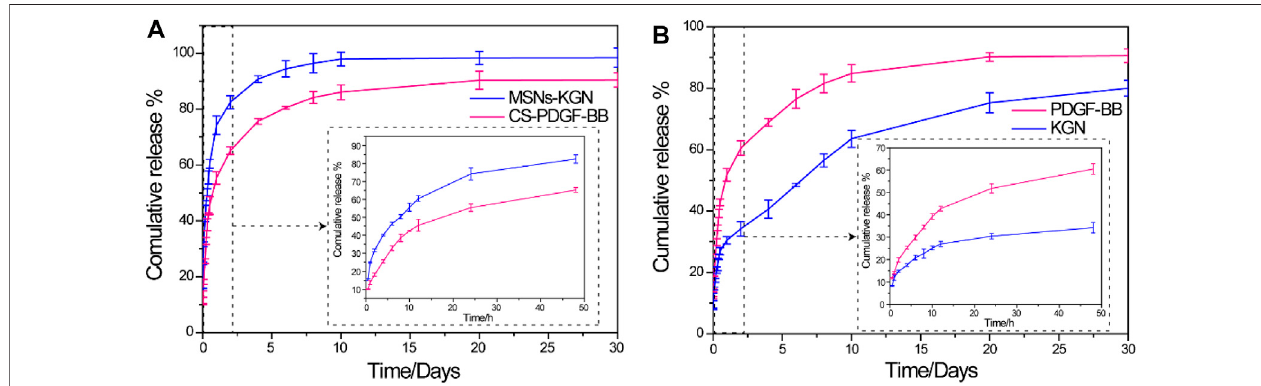
FIGURE3|(A) Invitro releasepro fi lesofKGNfromMSNsandPDGF-BBfromCSinPBSsolution. (B) Invitro releasepro fi lesofPDGF-BBandKGNfromCS/MSNs composite microspheres. Date was shown as mean ± SD, n =